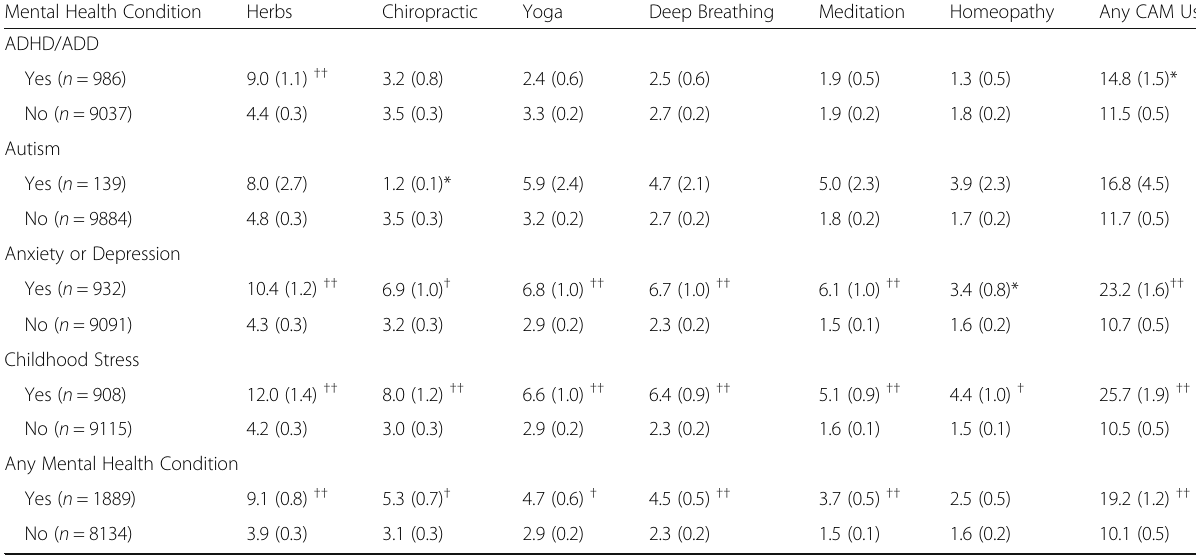
Table 2 Percent CAM use (standard error 1 ) for top six CAM approaches used among children aged 4 – 17 without and with common mental health conditions in the NHIS child CAL supplement